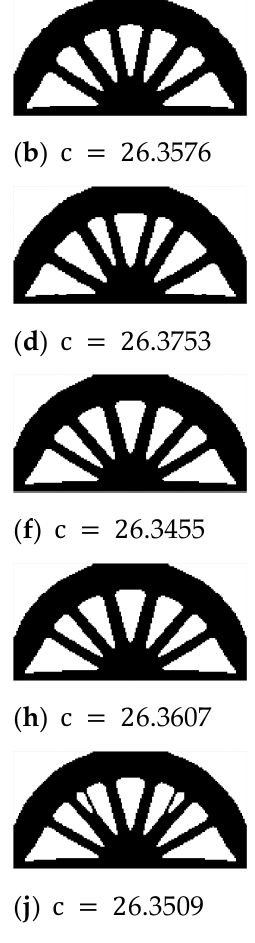
Figure 10. Final results from 10 runs of half-wheel beam.